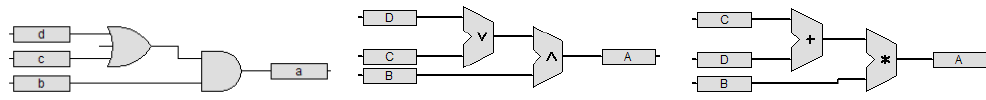
Figure 6. (bit) a = c&(c|d), (Word) A = B&(C|D), A = B*(C + D).